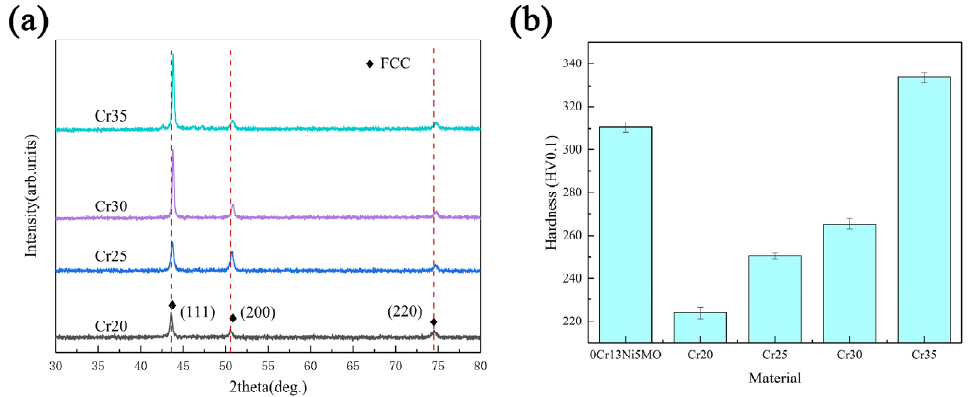
Figure 6. The surface morphologies of CoCr x FeMnNi HEA coatings: ( a ) Cr20, ( b ) Cr25, ( c ) Cr30, and ( d ) Cr35.